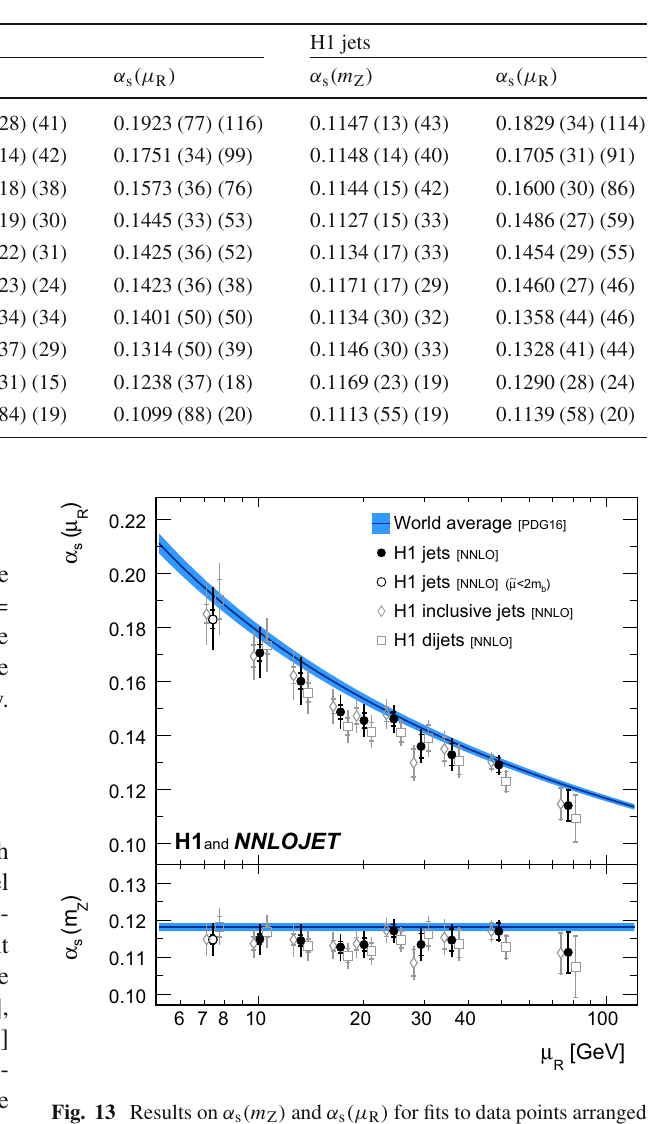
corresponds to the experimental (theory) uncertainty. The theory uncer- tainties include PDF related uncertainties and the dominating scale uncertainty